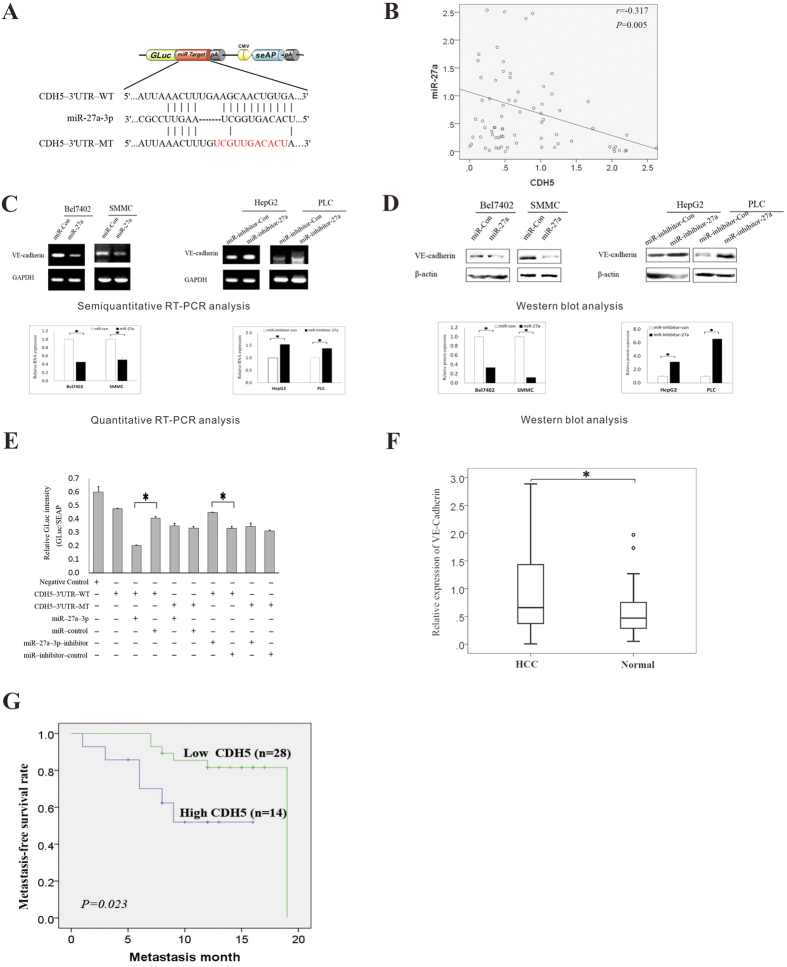
miR-27a-3p targets the 3′-UTR of the VE-cadherin gene and down-regulates VE-cadherin expression.(A) The sequences of the predicted miR-27a-3p binding site and the VE-cadherin (CDH5) 3′-UTR segments containing the wild-type or mutant binding site are shown. (B) qRT-PCR was performed to analyze the expression of miR-27a-3p and VE-cadherin in human HCC tissue. mRNA expression (C) and protein expression (D) of VE-cadherin in Bel7402 and SMMC cells transfected with miExpress™ Precursor miRNA Expression Clone miR-27a-3p (referred to as miR-27a) and in HepG2 and PLC cells transfected with miArrest™ miRNA Inhibitor Expression Clone miR-27a-3p (referred to as miR-inhibitor-27a). In immunoblotting assay, gels have been run under the same experimental conditions. Then cropped blots were incubated with different primary antibodies for analysis of signaling pathway. Full-length blots are included in the (supplementary information Fig. S5) (E) The relative luminescence intensities of GLuc and SEAP were analyzed after the wild-type or mutant 3′-UTR reporter plasmid was co-transfected with miR-27a-3p, miR-control, miR-27a-3p-inhibitor, or miR-inhibitor-control into 293T cells. The histogram shows the mean values ± SD of the normalized GLuc intensity (GLuc/SEAP ratio) from three independent experiments. (F) qRT-PCR was performed to determine the mRNA levels of VE-cadherin in clinical HCC specimens. The relative expression values are shown in scatter plots. The median expression level is indicated by a horizontal line. The VE-cadherin abundance was normalized to the abundance of U6. (G) Kaplan-Meier survival curves of patients with HCC indicated that higher VE-cadherin expression was significantly associated with early metastasis of HCC (*p < 0.05).